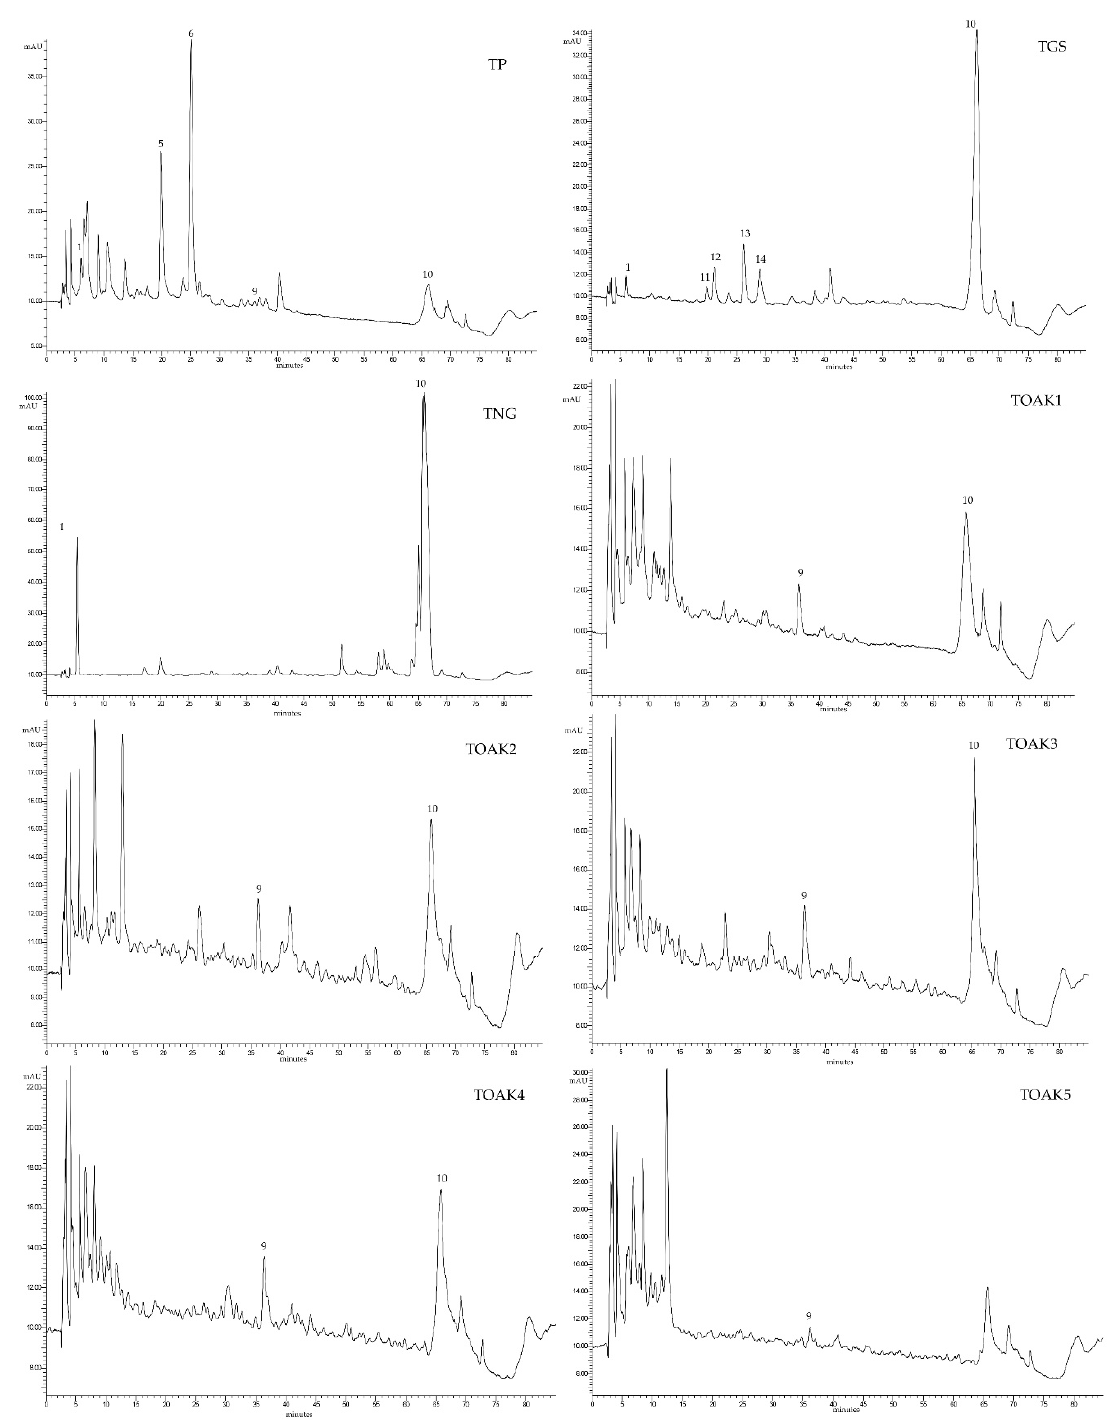
Figure 2. Chromatographic profiles at 280 nm of tannins in model wine solutions with the main peaks identified: 1, gallic acid; 5, α -punicalagin; 6, β -punicalagin; 9, ellagic acid; 10, polymeric tannins; 11, procyanidin B1; 12, ( + )-catechin; 13, ( − )-epicatechin; 14, procyanidin B2. TP, Pomegranate tannin; TGS, grape seed tannin; TNG, Nut gall tannin; TOAK1–5, Oak tannin 1–5.